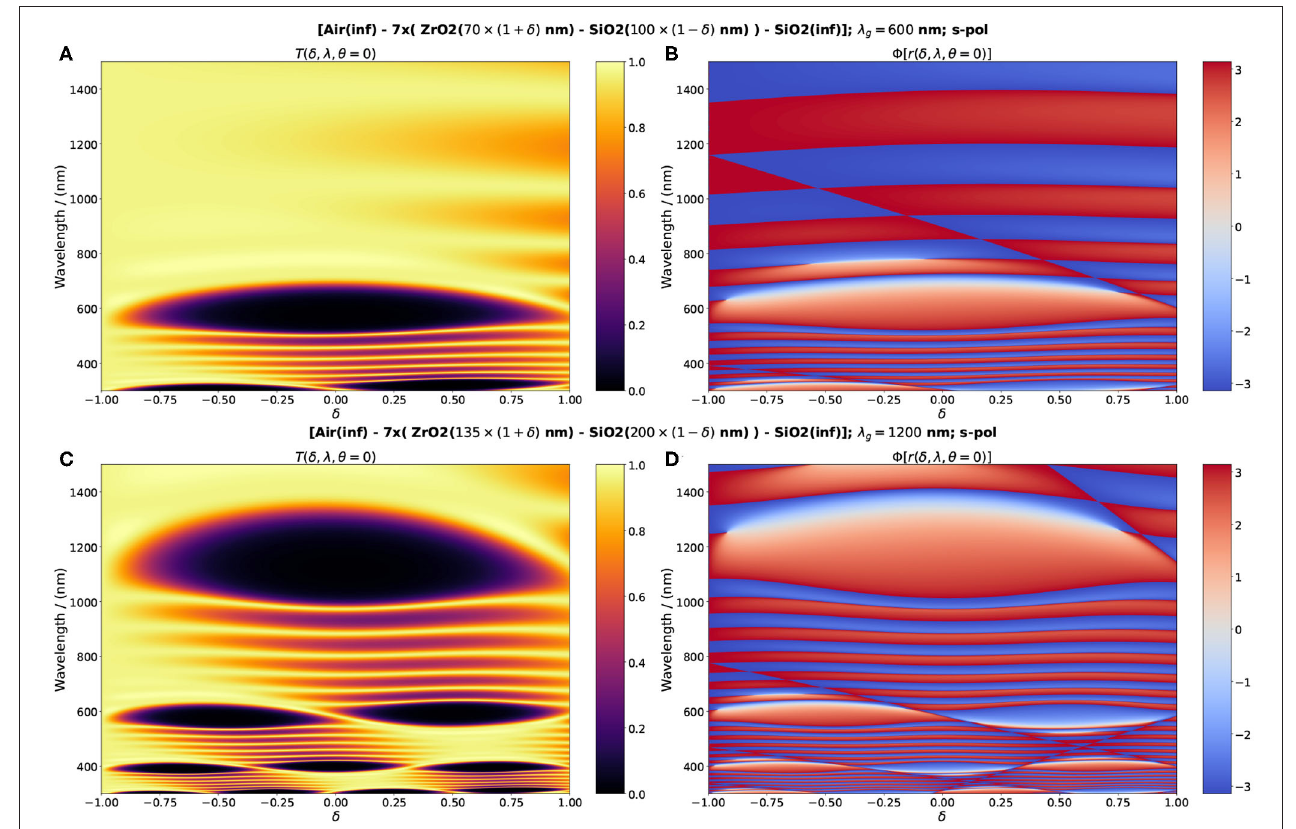
FIGURE 9 | Transmittance, (A,C) , and phase of the reflection coefficient, (B,D) , of photonic crystals with 7 unit cells on a silica substrate. In the upper row the a 0 (1 b 0 (1 δ ) nm and the layer with lower refractive index has a thickness b δ ). The initial values of layers thickness of the layer with higher refractive index is a = + = − are a 0 70 nm and b 0 100 nm, respectively. In the lower row the values are a 0 135 nm and b 0 200 nm. The choice of the initial thickness of each layer was = = = = determined by the central wavelength and the first bandgap. λ 600 nm in the upper row and λ 1,200 nm in the lower row. The parameter δ varies between –1 = = and 1. The tuning of optical Tamm states is achieved by combining two photonic crystals with layers thickness corresponding to overlapping bandgaps in energy and symmetric gradients (blue and red) of the phase of the reflection coefficient at a predefined